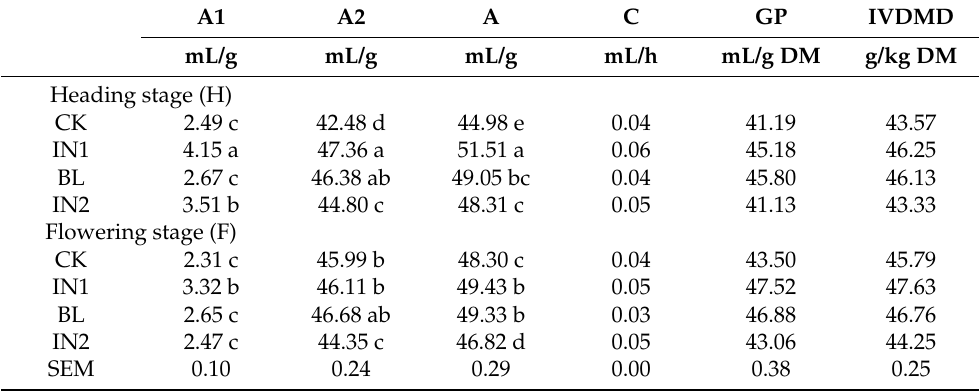
Table 5. In vitro ruminal fermentation parameters and DM digestibility of perennial oat silages treated without (CK) or with local LAB inoculant (IN1), commercial LAB inoculant (IN2), and sodium benzoate